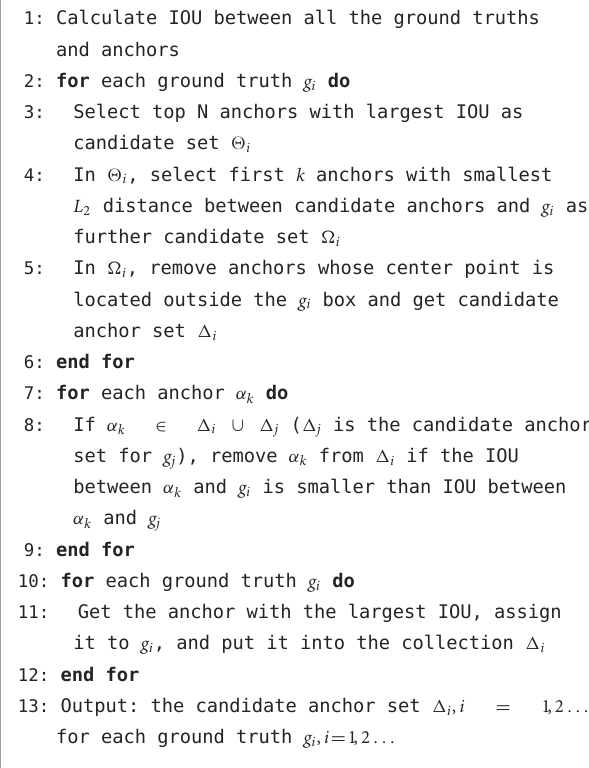
Algorithm 1. Proposed matching